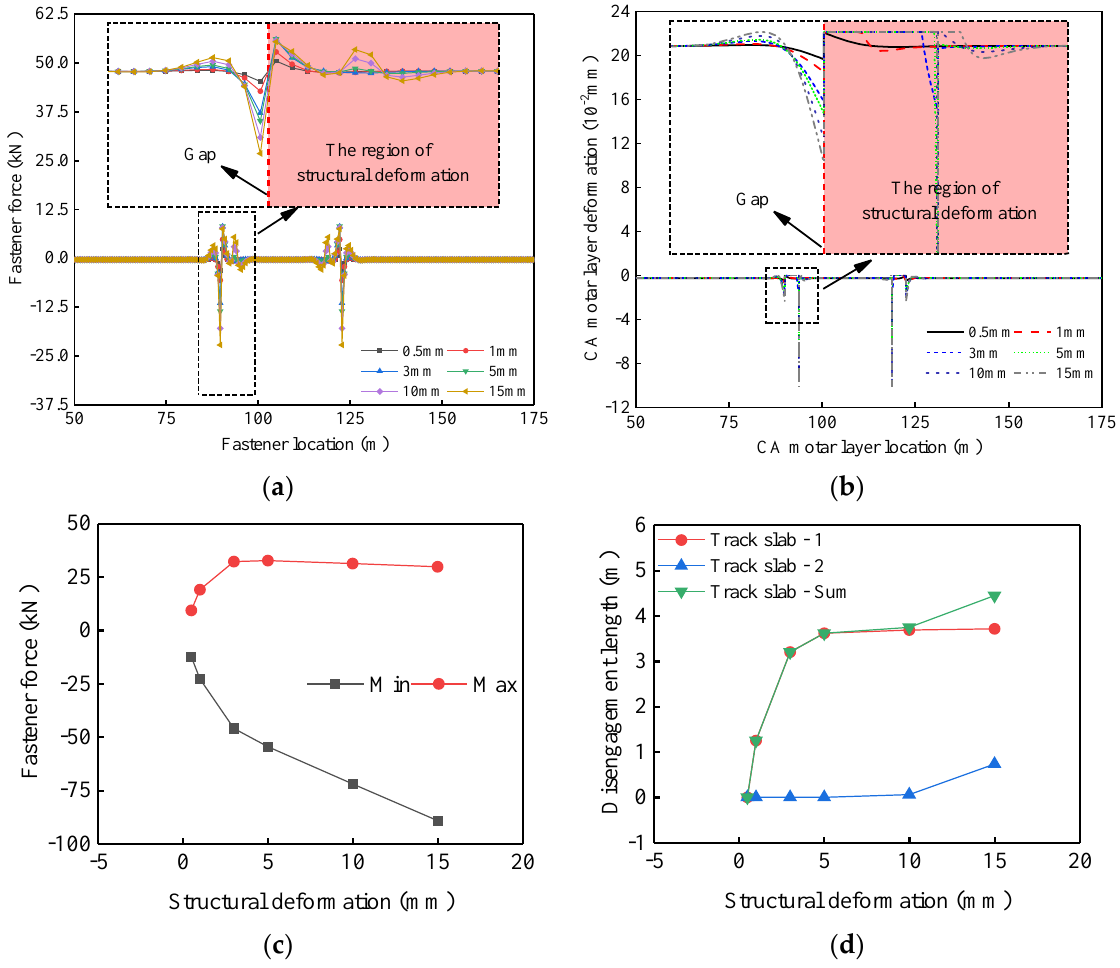
Figure 10. Variation of interlayer contact characteristics of track structure with girder vertical fault: ( a ) variation of fastener forces distribution; ( b ) variation of CA mortar layer deformation distribution; ( c ) variation of fastener force extremum; ( d ) variation of track slab disengagement length.